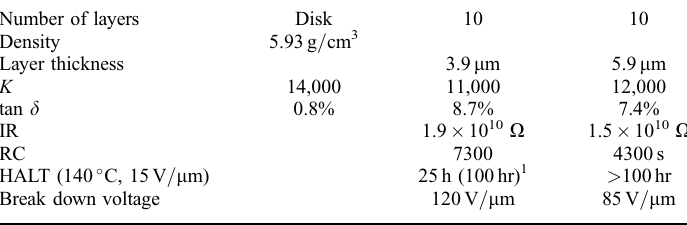
TABLE III Electrical Properties of RDAD163N: Disks and 6 m m and 4 m m